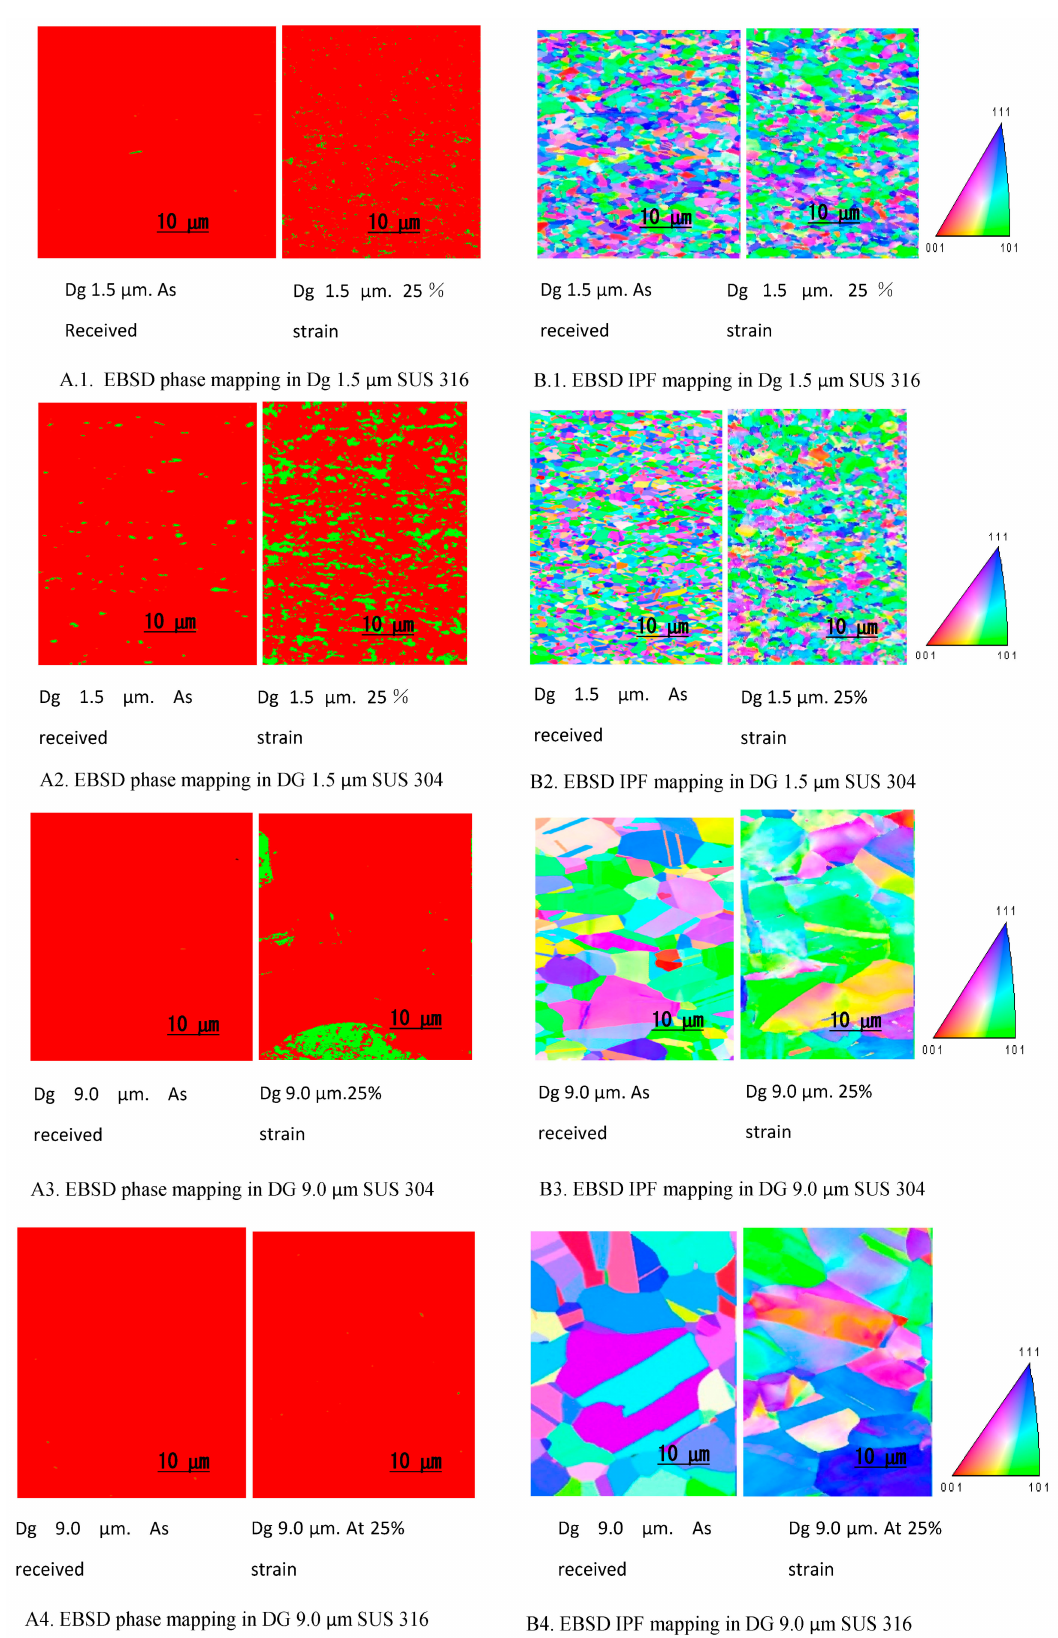
Figure 8. SEM-EBSD mapping for SUS 304 and SUS 316 thin metal